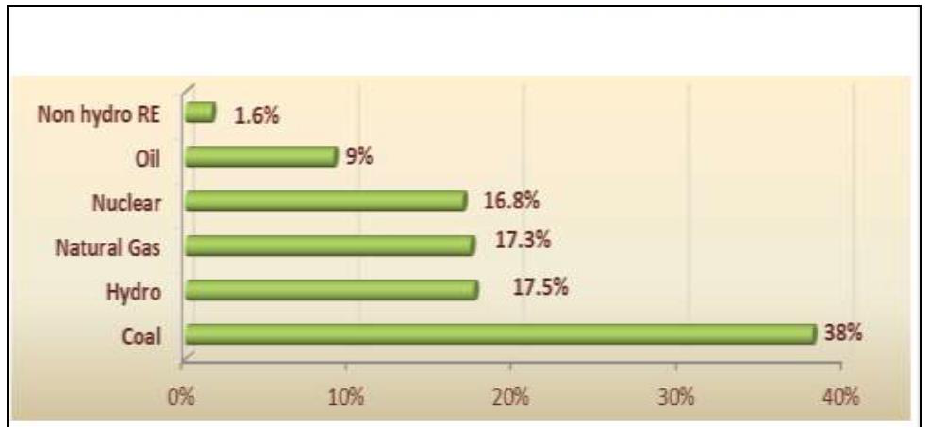
Figure 8. Global share (%) of fuel for electricity generation. Reproduced with permission from